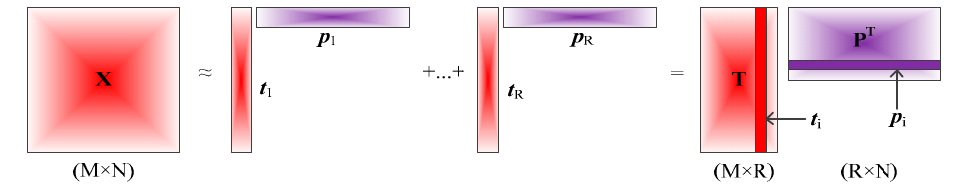
Figure 1. Matrix X decomposition of rank one (CP decomposition).